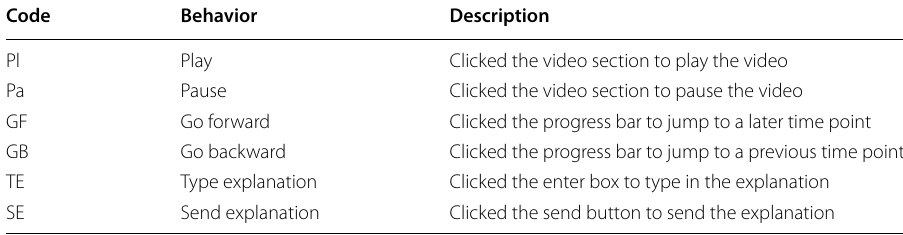
Table 1 The log data coding system